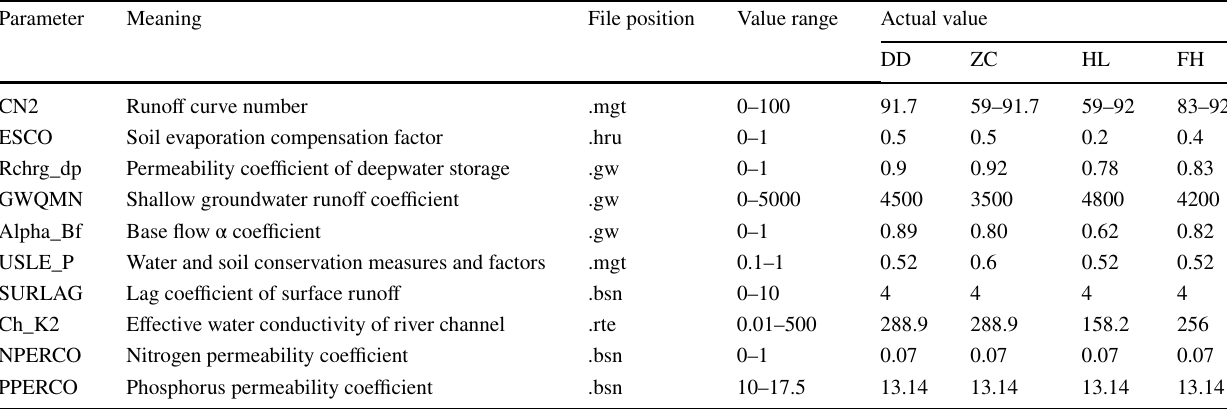
Table 2 Final values of calibration parameters